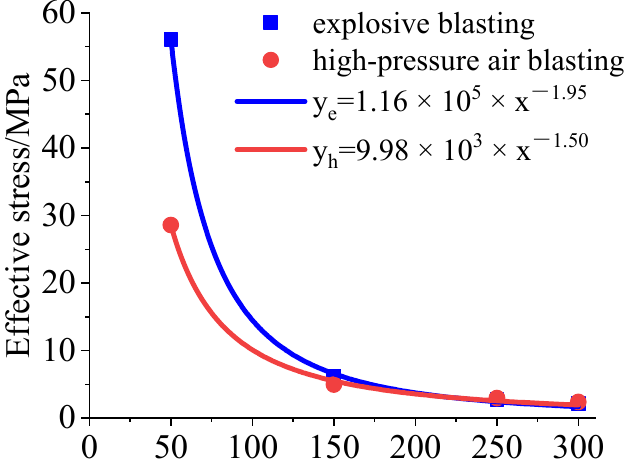
Figure 7. The attenuation fitting curve of the peak effective stress.